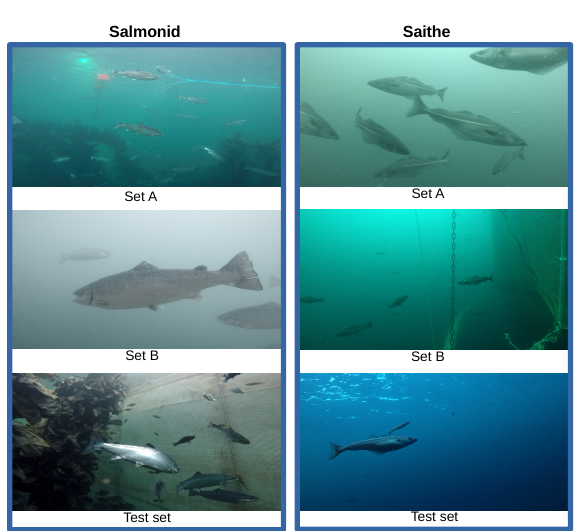
Figure 6: Sample images from the different video sets for each of the species: Salmonids (left col- umn) and Saithe (right column)